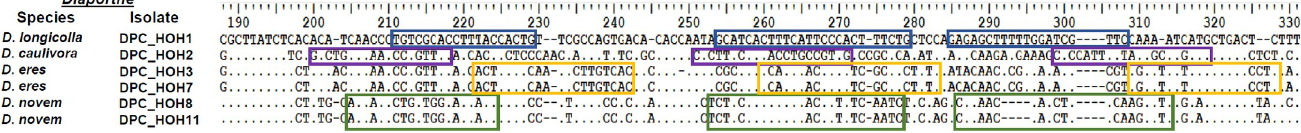
PLOS ONE | https://doi.org/10.1371/journal.pone.0257225 September 10,